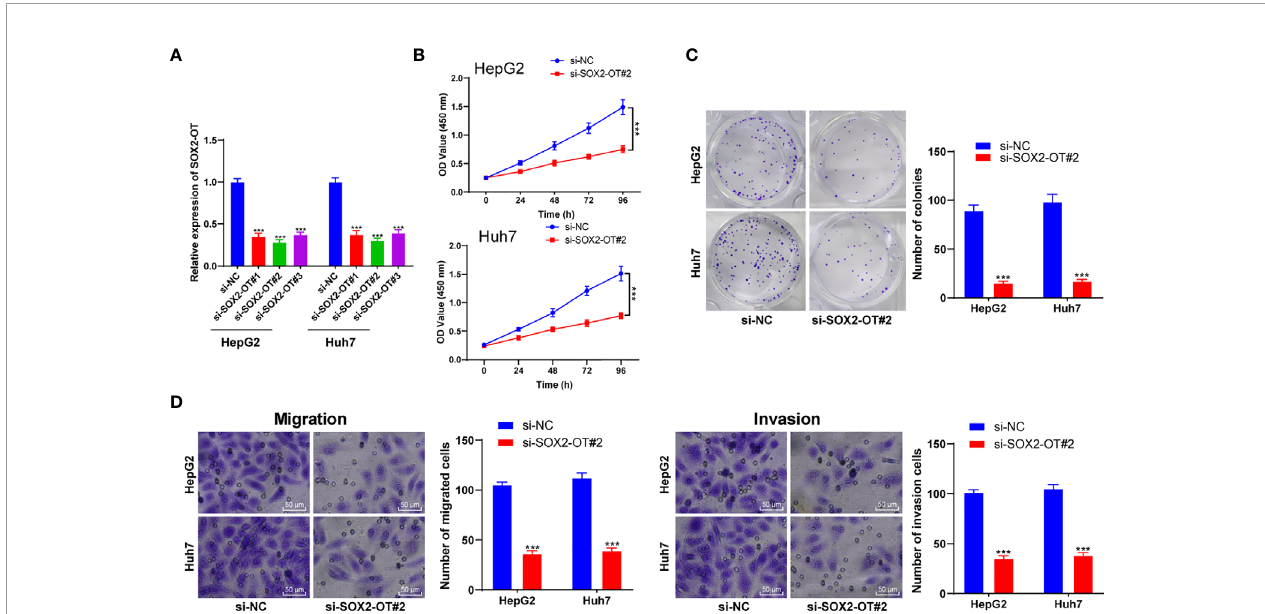
FIGURE 2 | Downregulation of SOX2-OT inhibited proliferation and invasion of HCC cells. SOX2-OT was intervened by siRNA (si-SOX2-OT#1, si-SOX2-OT#2, si-SOX2-OT#3) in HepG2 and Huh7 cells. The transfection of si-NC was used as control, and (A) the intervention effect of si-SOX2-OT was veri fi ed by RT-qPCR; the effects of si-SOX#2-OT2 with the best interference ef fi ciency on cell proliferation, migration, and invasion were detected by (B) CCK-8 and (C) colony formation assay and (D) Transwell assays. Cell experiment was repeated three times independently and data were all metrological data. All data were shown as mean ± standard deviation. One-way ANOVA was used for data analysis, followed by Tukey ’ s test. *** P <